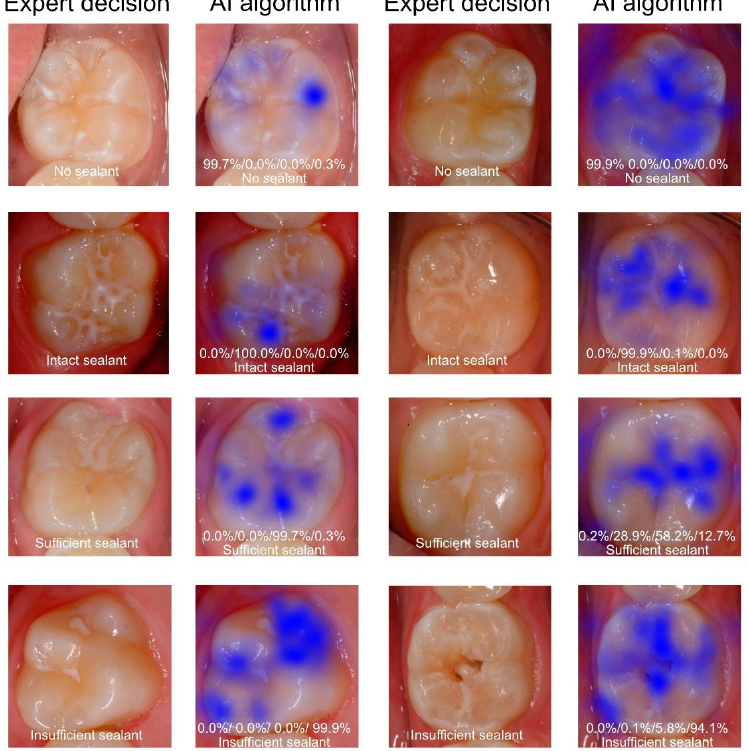
Figure 4. Examples of clinical images showing the reference decision and paired images with saliency maps visualizing the image areas (in blue) used in decision making by the AI method. The corresponding test results by the AI method are given for each example (unsealed tooth/intact fissure sealant/sufficient sealant/insufficient Table 1. Overview of the diagnostic performance of the developed convolutional neural network (CNN), where the inde- pendent test set ( n = 471) was compared against independent expert evaluation of the caries detection level. The calcula- tions were performed for different types of teeth, surfaces and training steps. In this context, the overall diagnostic accu- racy (ACC), sensitivity (SE), specificity (SP), negative predictive value (NPV), positive predictive value (PPV) and area under the receiver operating characteristic curve (AUC).